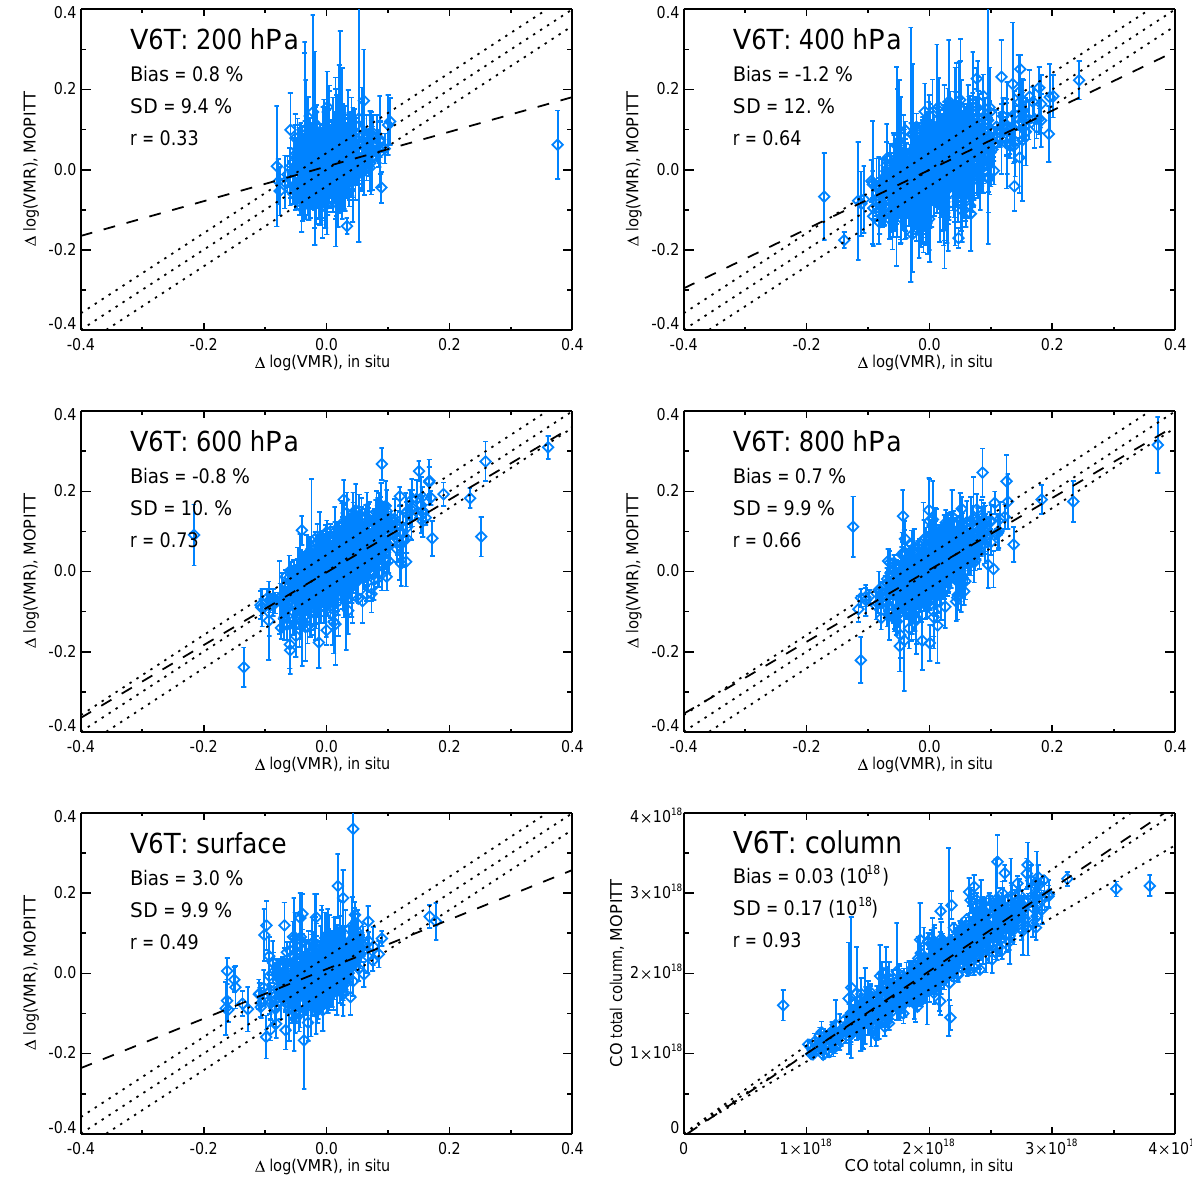
Figure 3. V6 TIR-only validation results based on the NOAA flask measurements. As discussed in Sect. 3.1, VMR validation results are presented in terms of log ( VMR ) , after subtracting a priori values. Dotted lines represent biases of − 10, 0 and 10%. Dashed lines are least- squares best fits. CO total column values as well as bias and standard deviation statistics for the total column are in units of moleccm − 2